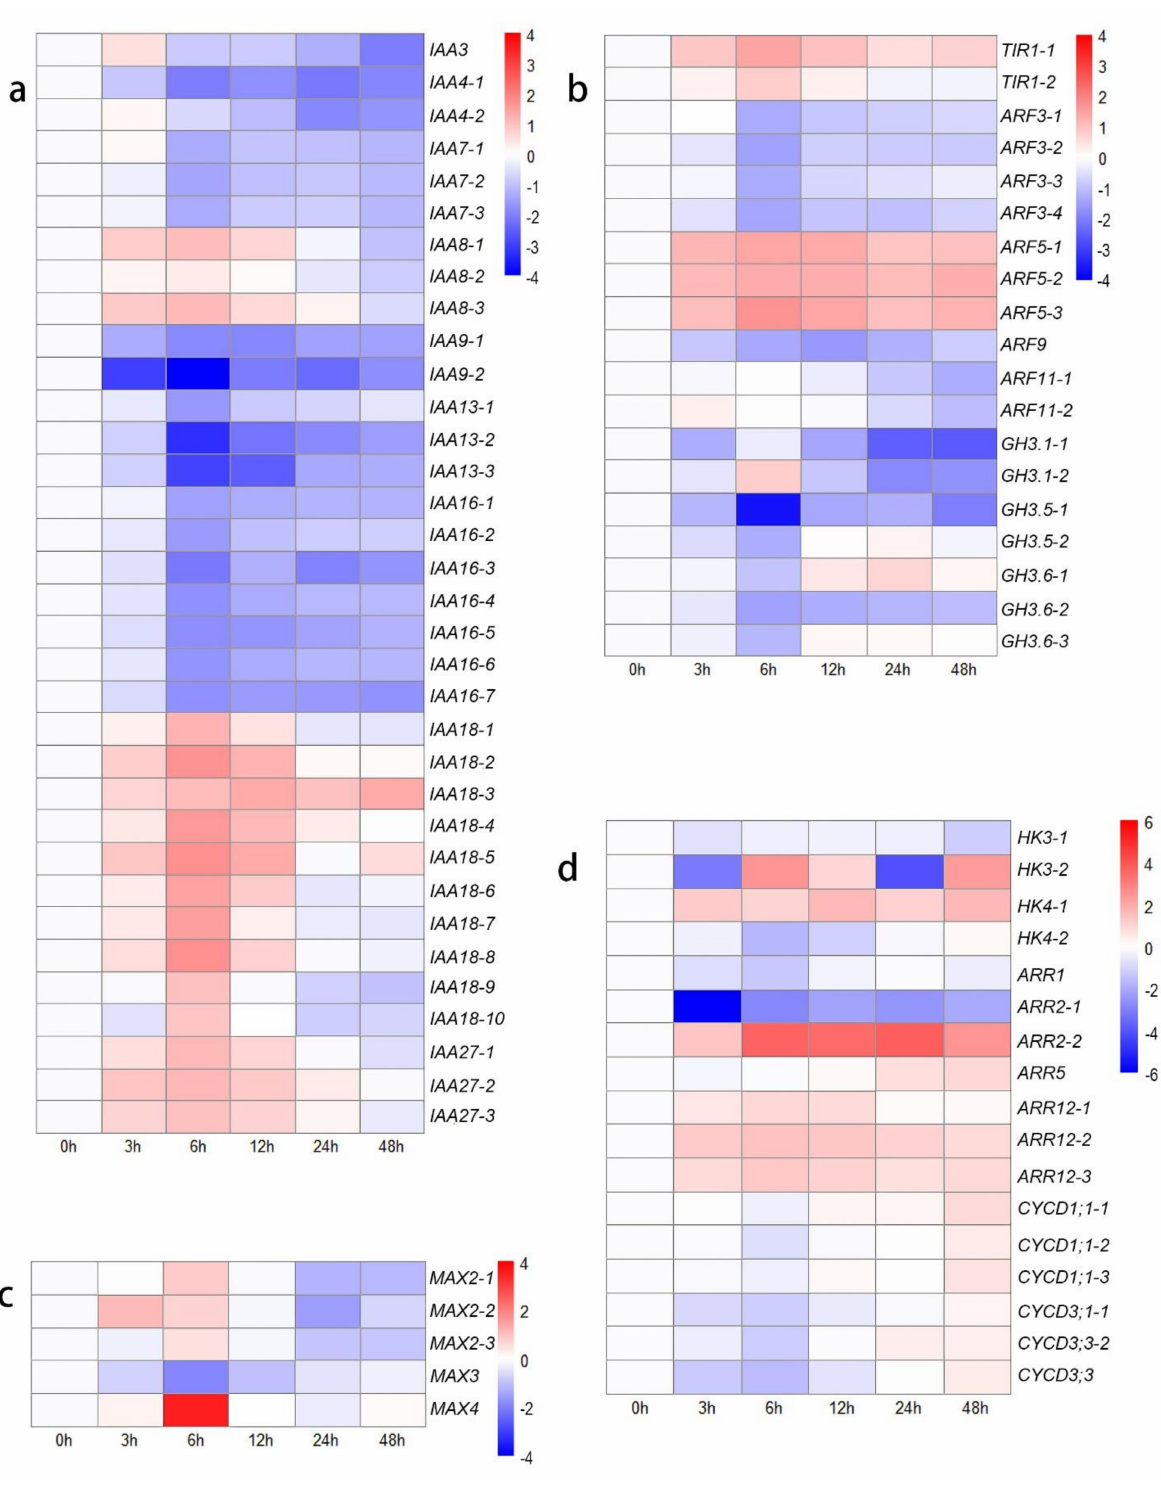
Figure 2. Heat map showing log2-normalized expression fold changes at each time point for hormone-related genes after decapitation. ( a ) IAA family genes; ( b ) TIR , ARF, and GH3 family genes; ( c ) SL-related genes; ( d ) CKs-related